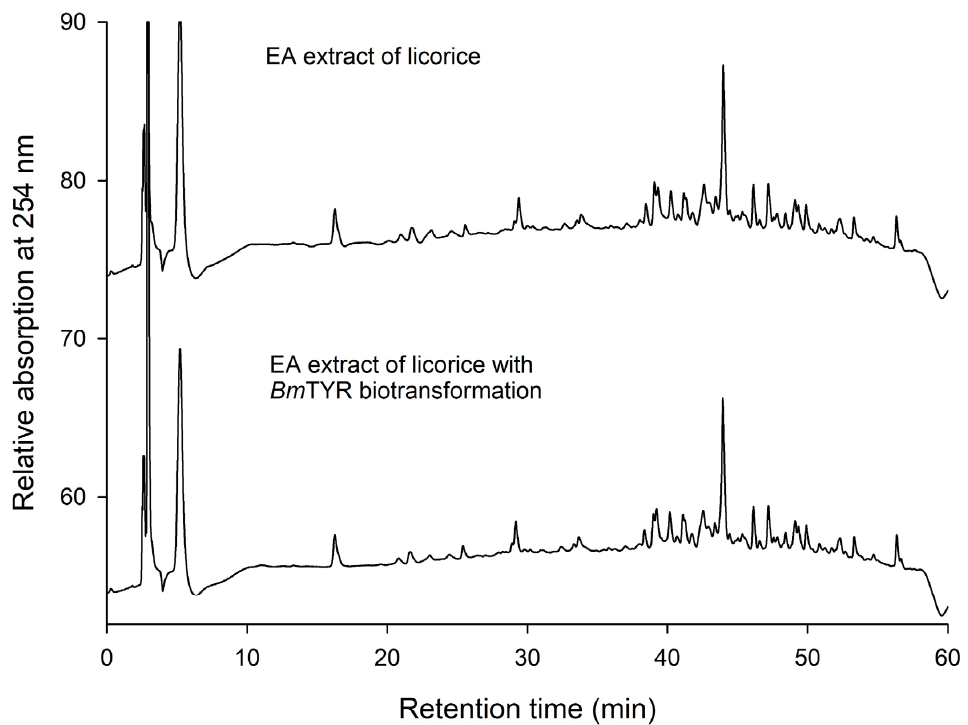
Figure 2. High-performance liquid chromatography (HPLC) analysis of the products biotransformed from the ethyl acetate (EA) extract of licorice using Bm TYR. The biotransformation mixture containing 108 μ g/mL of the purified recombinant Bm TYR enzymes, 2 mg/mL of the EA extract, 10 mM ascorbic acid, and 500 mM borate buffer at pH 9 was incubated at 50 °C and 200 rpm-shaking for 1.5 h. At the end of the reaction, one-fifth volume of 1 M HCl and an equal volume of MeOH were added to stop the reaction and was analyzed by HPLC. The HPLC operation procedure was described in Section 3.7.